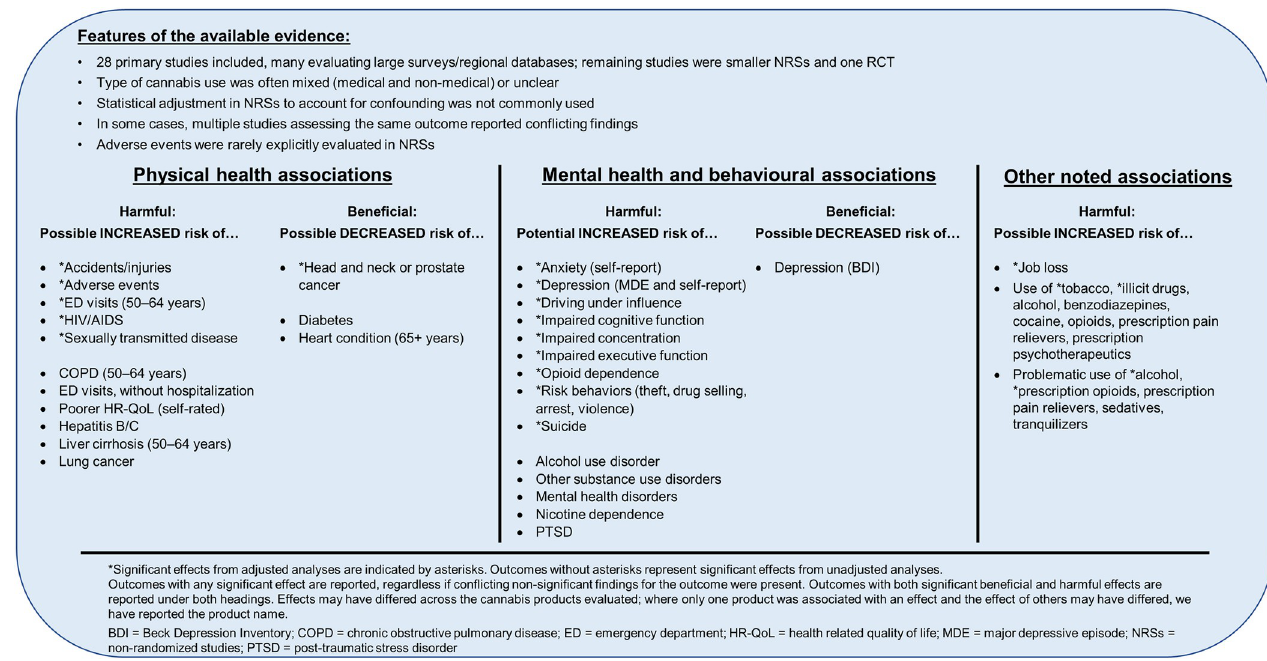
Fig 3. Synopsis of findings reported in population-based studies and studies of healthy older adults.